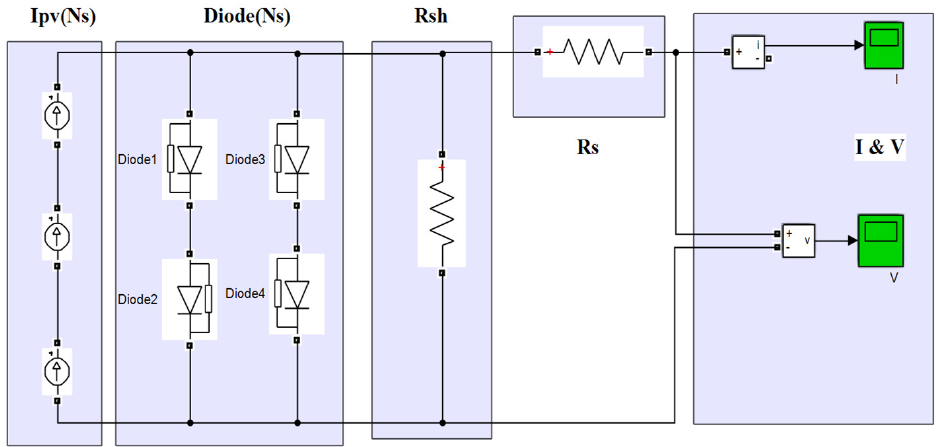
Figure 1. Equivalent model of series and parallel connected solar cells.